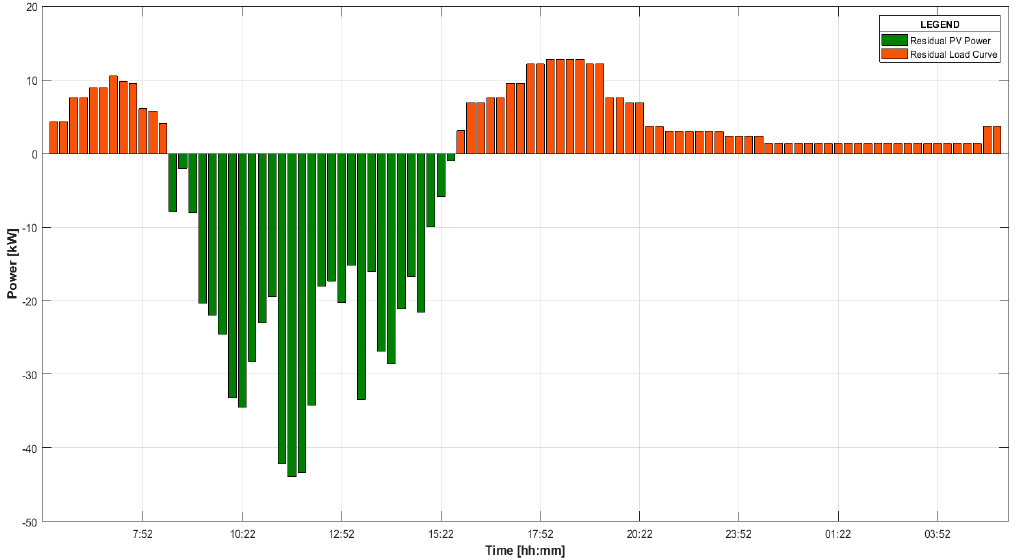
Figure 18. Net power production and power absorption distributions.